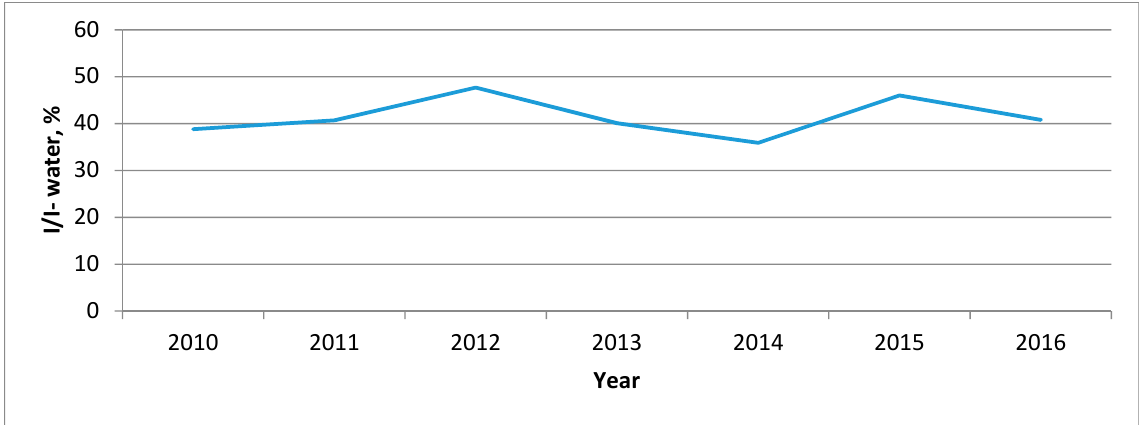
Table 10. Calculation of I/I-water for some big Swedish wastewater plants for 2009 and 2015 based on values of discharge and specific values of produced wastewater.